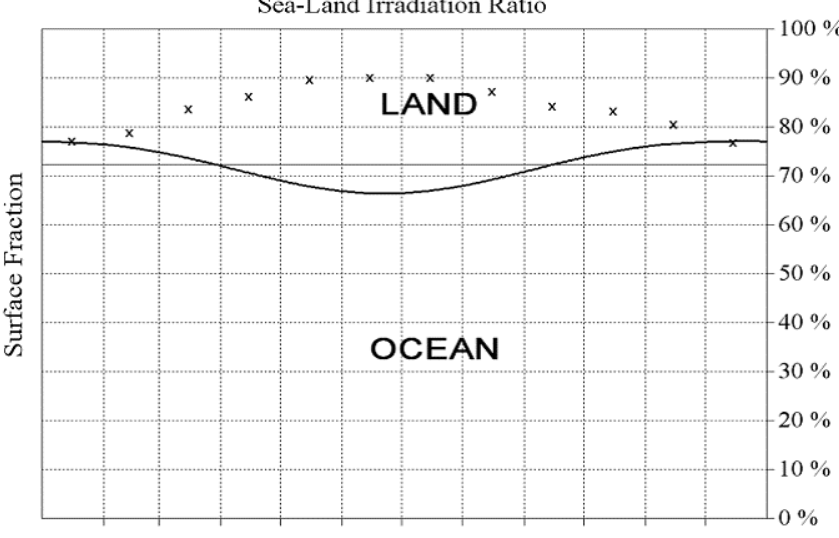
Figure 2. Annual course of the oceanic fraction of Earth’s daytime side. Of the terrestrial cross section astronomically exposed to sunlight, 72 % belong to the ocean surface on the annual average, with some slight seasonal course of the daily means (bold curve, Feistel, 2013 [64]). The crosses (x) represent a similarly weak seasonal cycle of the monthly mean relative humidity at St. Helena Island in the South Atlantic